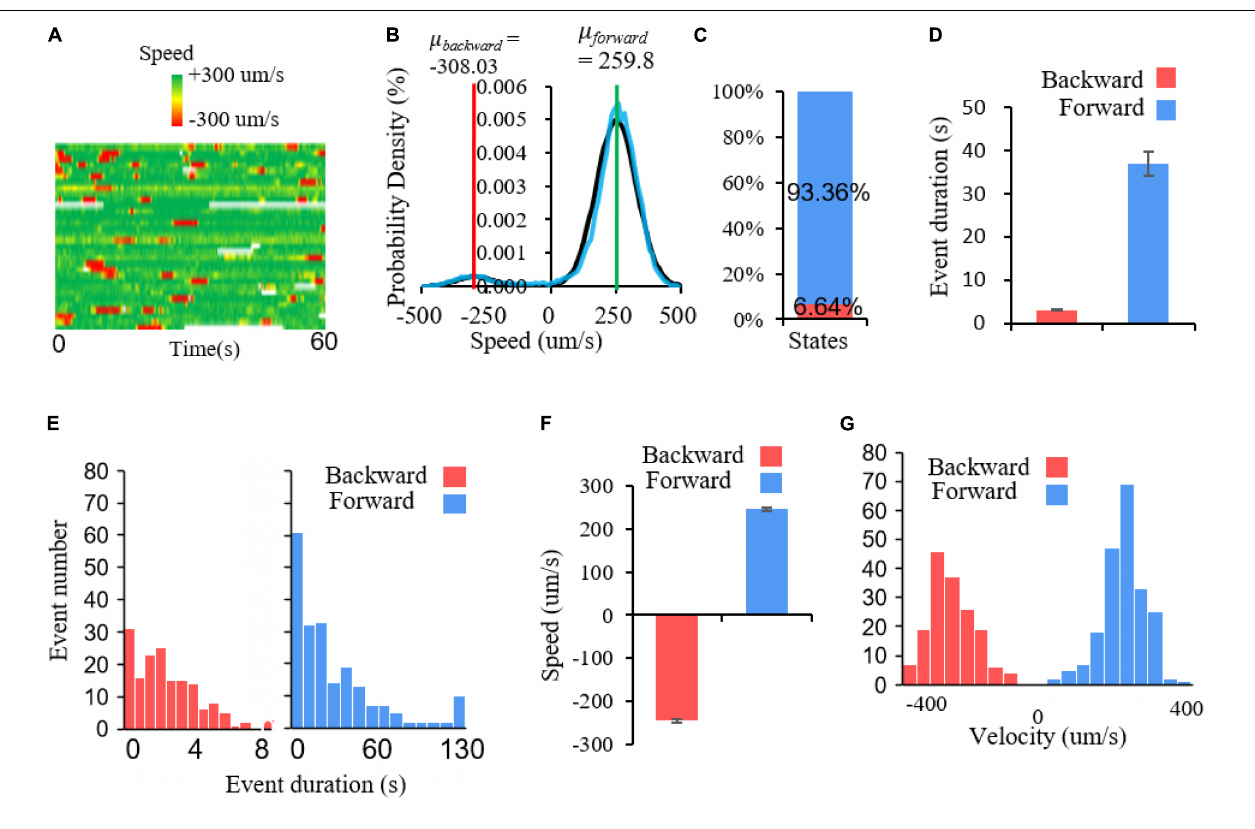
FIGURE 5 | Multiple locomotory states in C. elegans movement. (A) Speed heat map of a group of worms. Each row represents a speed trace, green and red represent forward and backward speed, respectively. (B) Probability density of speed distribution. The bimodal Gaussian function f ( x ) = 1 to fit C. elegans speed distribution. Black represents fitting curve and the blue represents raw speed distribution. The parameters for two models are: µ forward = 259.8, δ forward = 77.79164; µ backward = − 308.03, δ backward = 62.79239. (C) The percentage of two locomotory states. Forward movement accounts for 93.36% of locomotory time and backward movement only account for 6.64%. (D) Average duration for forward and backward events. T -test, p < 0.001. (E) The duration distribution of backward and forward events. Backward events: bin size = 0.6; forward events: bin size = 10. (F) Average speed of forward and backward events. N forward = 209, N backward = 164. (G) The speed frequency distribution of forward and backward events. Bin size = 44.